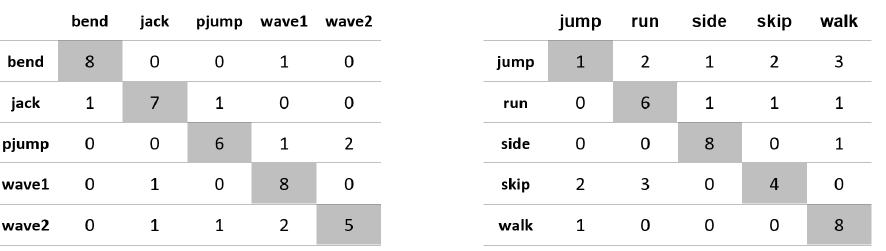
Figure A12. Confusion matrices for the experiment using the ‘lower-occlusion’ database, eccentricity and C1 correlation.